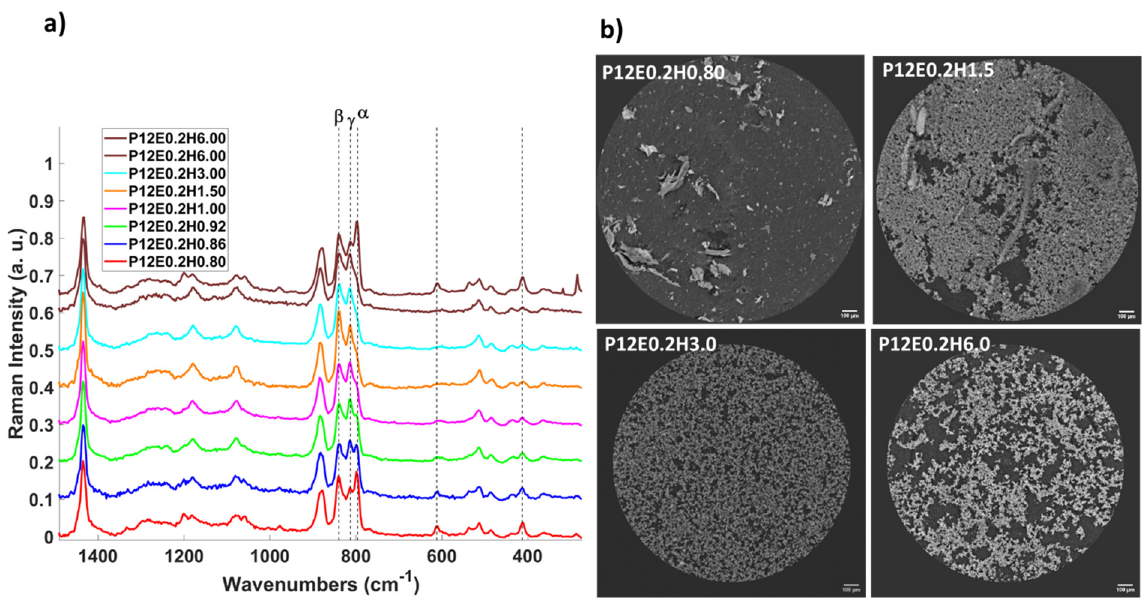
Figure 6. ( a ) Raman spectra of the aerogels prepared with 12 wt.% PVDF, x EtOH = 0.2, and variable PVDF/H 2 O ratio from 0.80 to 6.0. ( b ) Selected axial maximum intensity projections (MIP) of the aerogels prepared with 12 wt.% PVDF, x EtOH = 0.2, and variable PVDF/H 2 O ratio from 0.80 to 6.0. The remaining MIP µ CT slices are in the